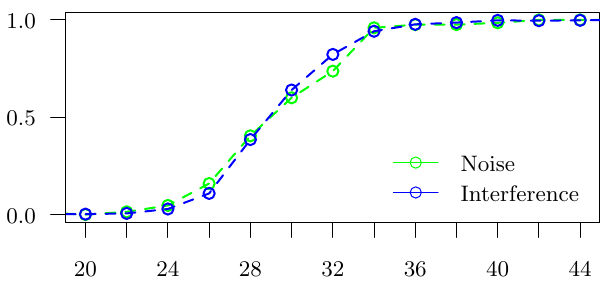
Figure 7: The frame reception rate with respect to the signal-to-noise ratio with noise only (green) or with noise and interference